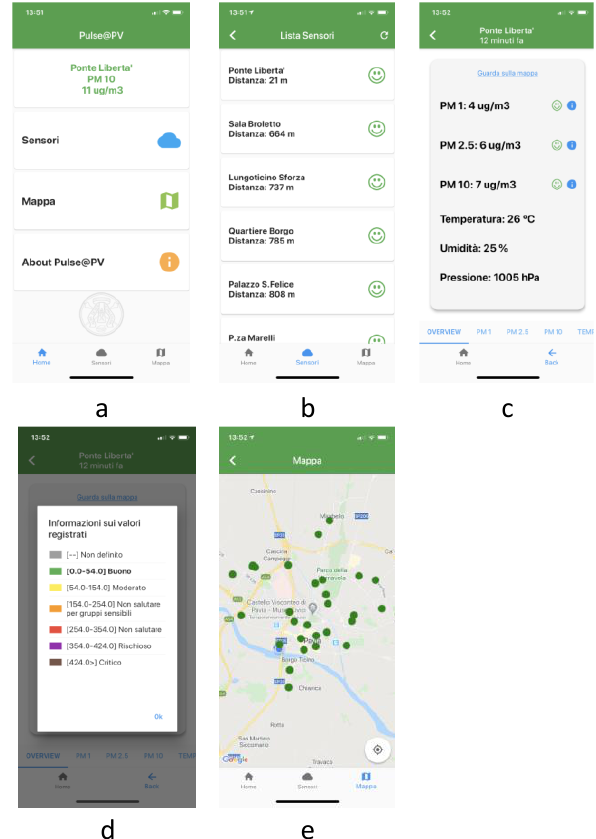
Figure 6. Screenshots of the Pulse@PV App. a. home page;